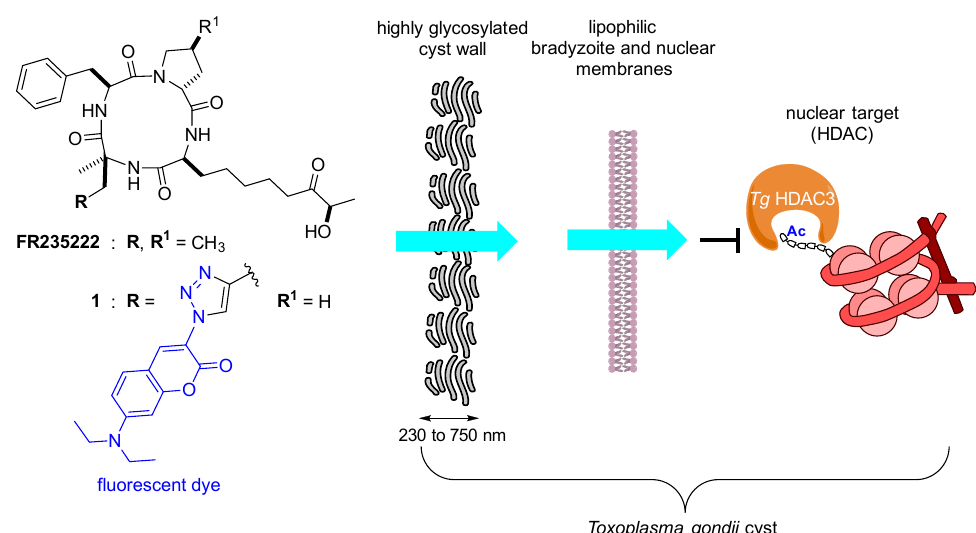
Figure 1 . Natural product FR235222 and its fluorescent coumarin triazole analogue 1 . In T. gondii , the cyst wall, the bradyzoite external membrane, and its nuclear membranes are the barriers that must be overcome for these compounds to reach their nuclear target, Tg HDAC3.